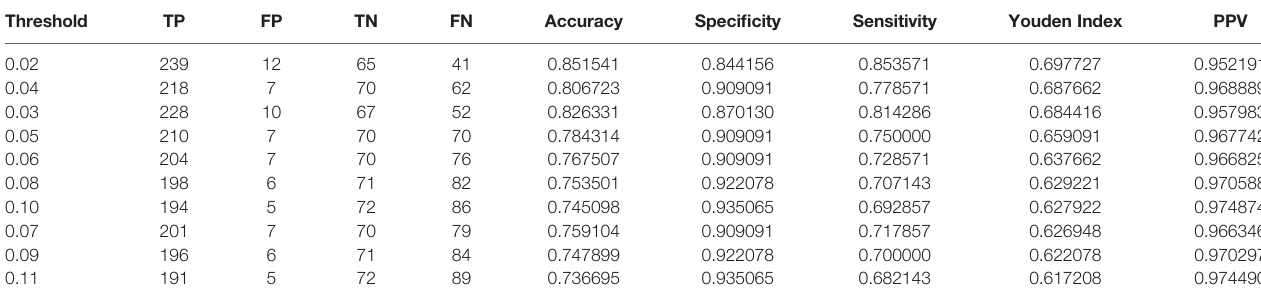
TABLE 2 | The results of test set 1 showing the top 10 data in descending order of Youden index, with a Threshold-value range of 0.01 to 0.99, containing 99 values. Threshold TP FP TN FN